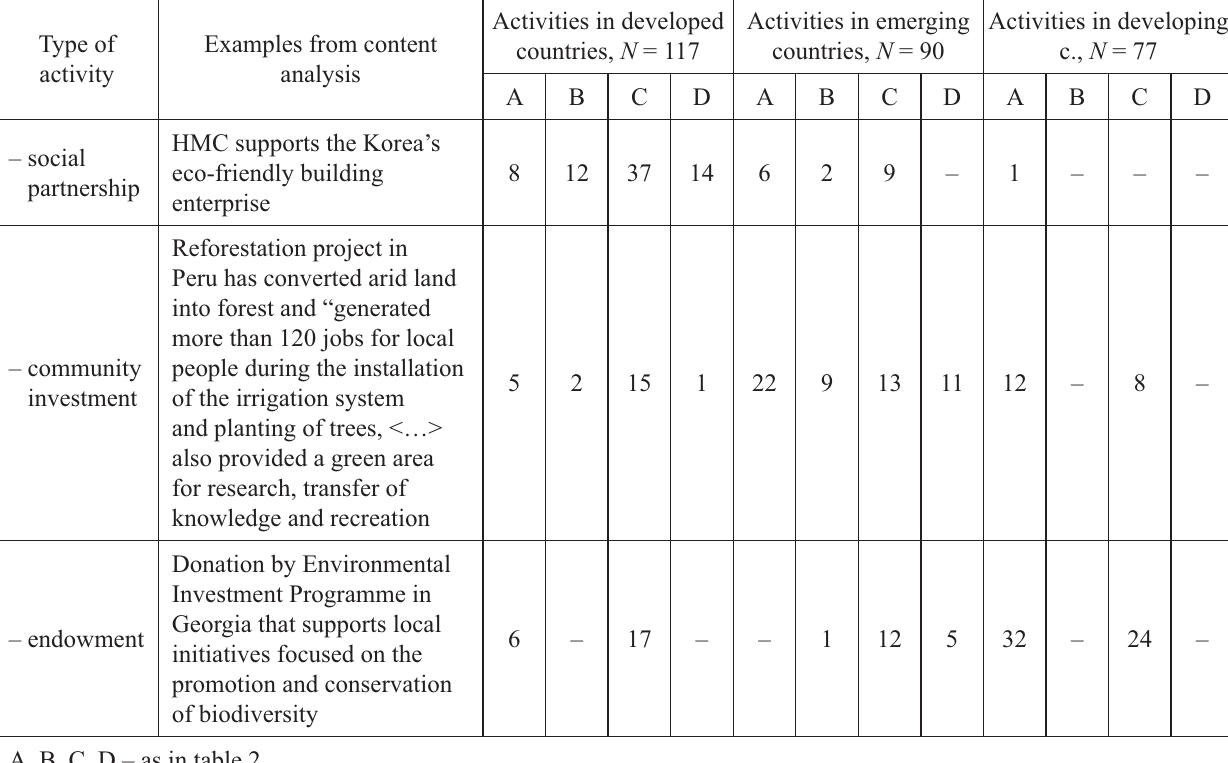
Table 6. MNEs commitment to environmental issues in developed, emerging and developing countries Type